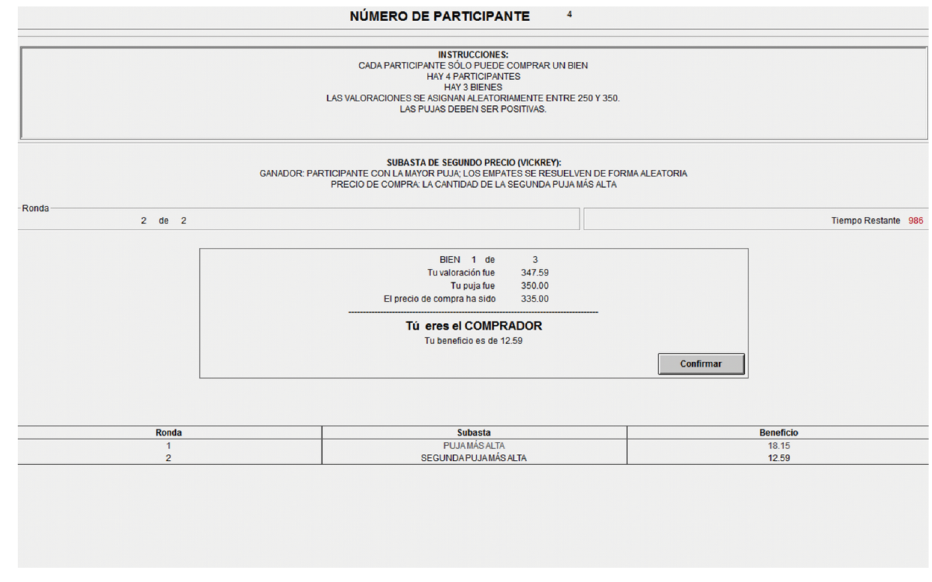
Figure A1.6. Winner of S